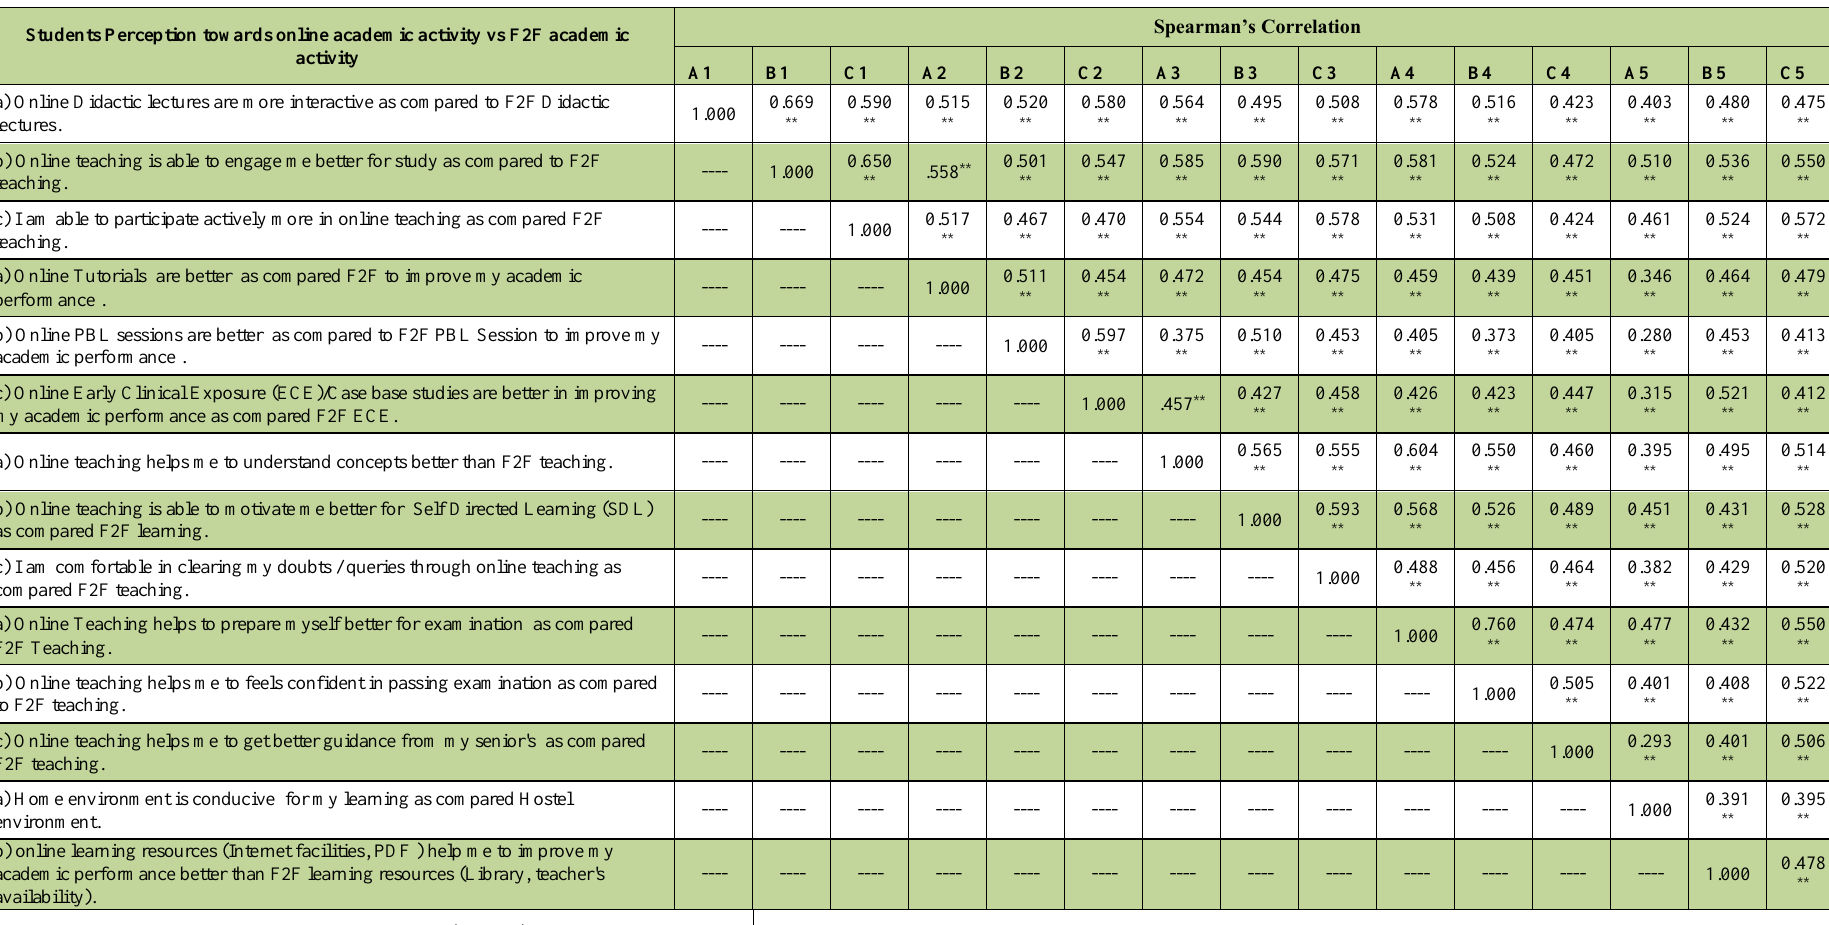
Table 2. Spearman’s correlation between the questions of student’s perception towards online and F2F academic